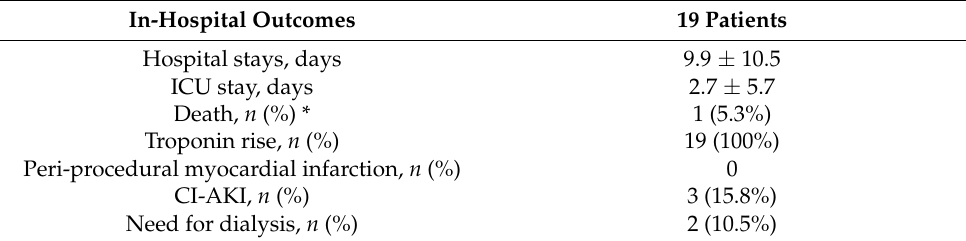
Table 3. In hospital complications.